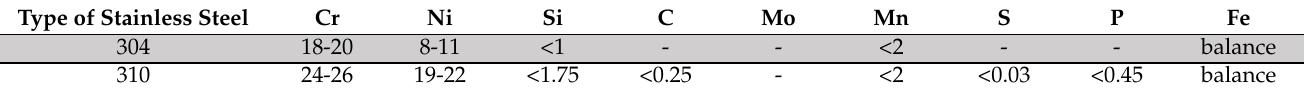
Table 2. Chemical composition of stainless steels (wt%)